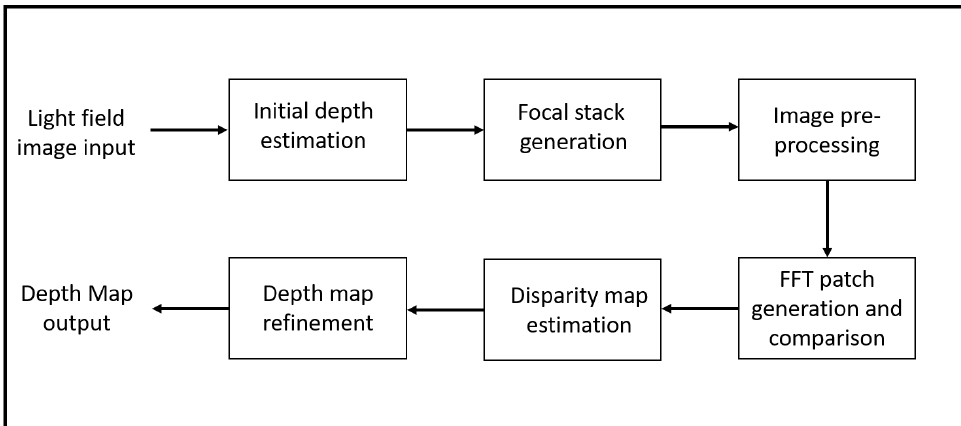
Figure 5. Flow of the proposed